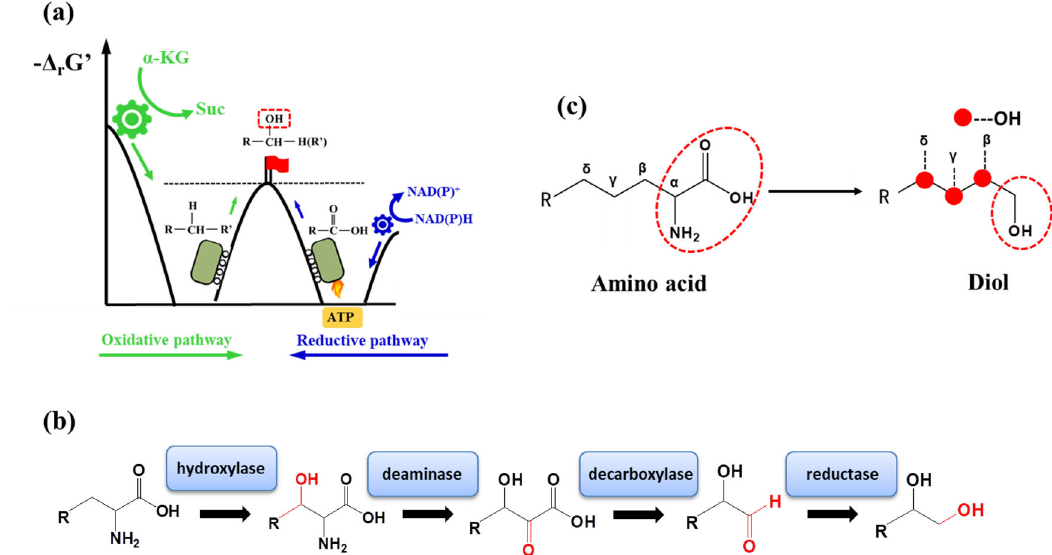
Fig. 1 Schematic representation of the principle and platform pathway proposed in this study for producing diols from amino acids. a Principle of two strategies that natural enzymes employ to overcome the thermodynamic barriers (black dashed line) for the formation of hydroxyl group from hydrocarbon by oxidation (left) and from carboxyl group by reduction (right). In the oxidative pathway, the oxidation of alkyl group is often coupled with an exergonic reaction (shown is the oxidation of α -ketoglutarate ( α -KG) to succinate used in this study) (green arrow). In the reductive pathway using NAD(P)H as reducing power, ATP is normally needed as an additional energy supply (blue arrow). b The proposed pathway comprises four cascade reactions, which are successively catalyzed by amino-acid hydroxylase, L -amino acid deaminase, α -keto acid decarboxylase, and aldehyde reductase, respectively. Functional groups colored in red represent the groups modi fi ed in each step. Hydroxylation at β -position is shown only for illustration purposes. c Illustration of synthesis of diverse branched-chain diols. One hydroxyl group is formed from the amino carboxyl group via Ehrlich pathway (red dotted circles), while the other one is attached to the β -, γ -, or δ -C atom of alpha-amino acid as determined by the property of hydroxylase